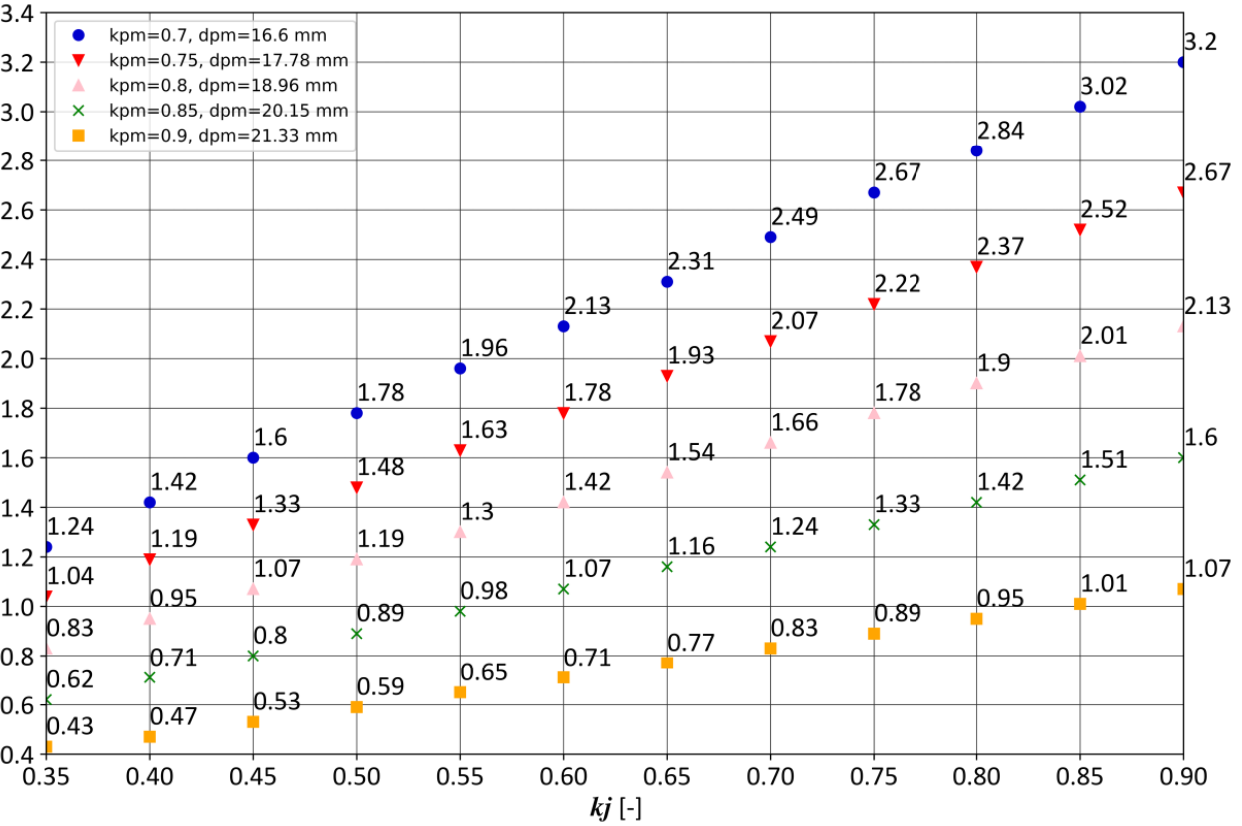
Figure 6. Supplement of Figure 5 with dimensions of dpm and wj depending on the kj / kpm configuration.